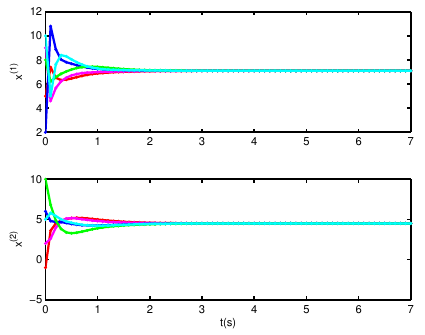
Figure 6. States of followers with symmetric